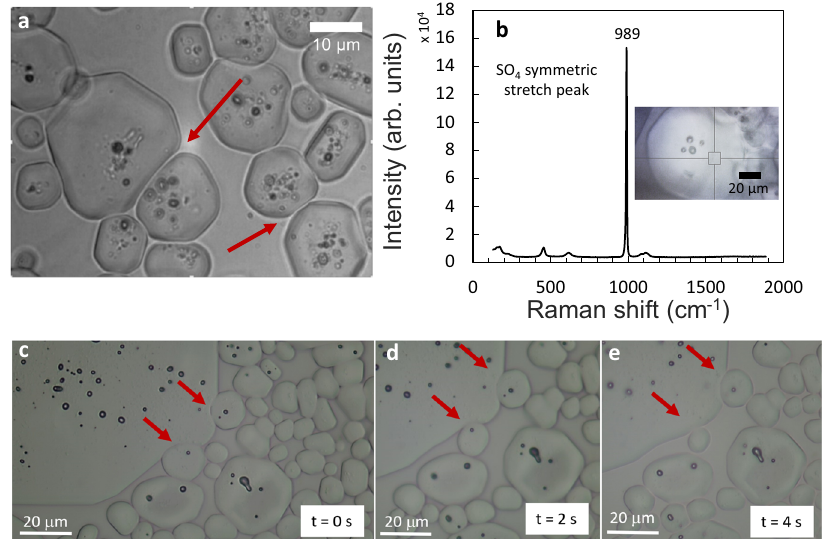
crystals identi fi ed asmirabilite. c – e The red arrows point to local deformation of a large mirabilite crystal, which is reversed once the strain is removed.